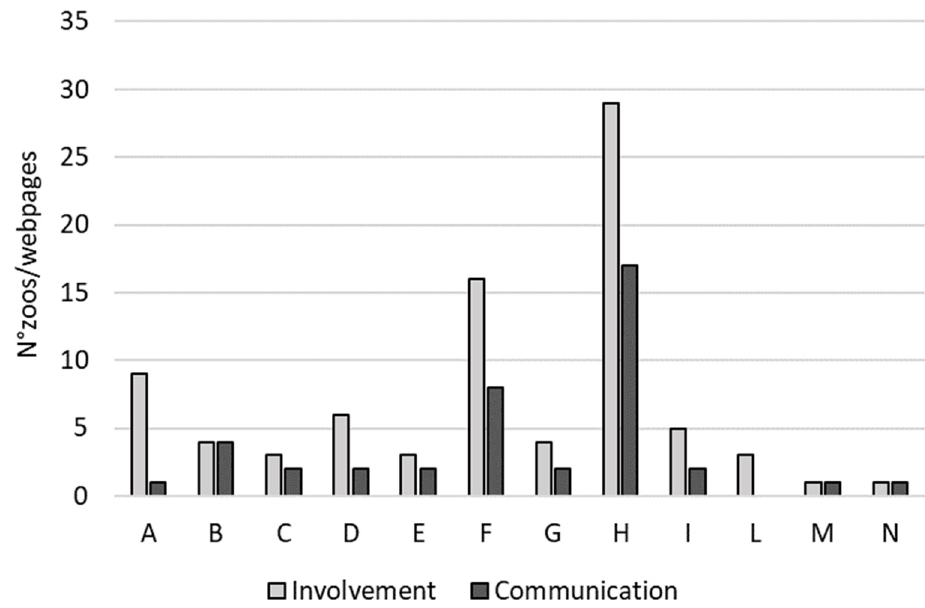
Figure 2. For each project (from A–N), the bar plot shows the number of zoos involved (Involvement) and the number of dedicated zoo-webpages (Communication).